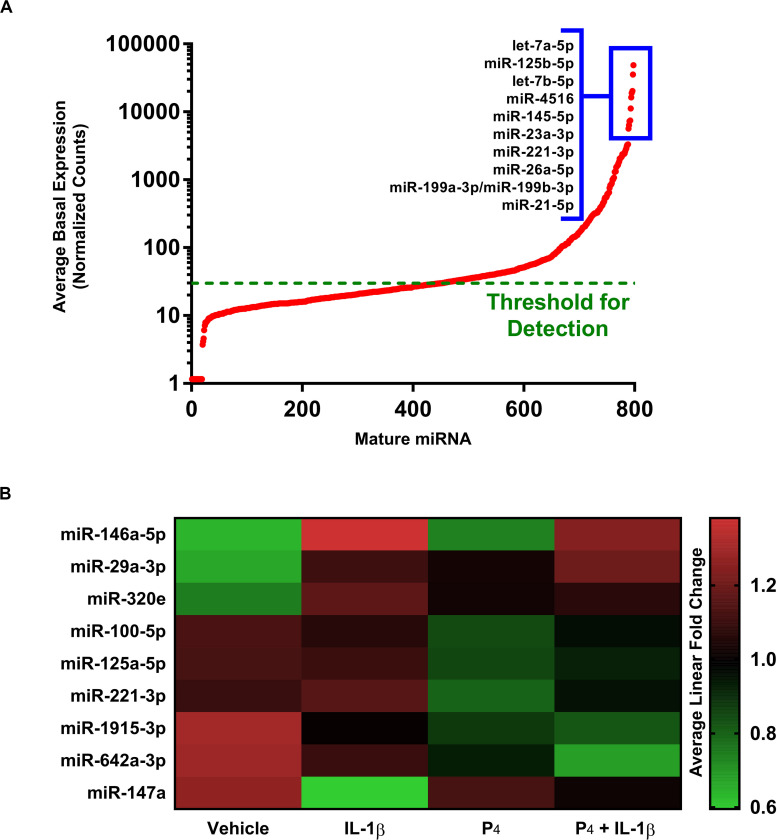
Differential expression of microRNAs in cervical stromal fibroblasts stimulated with IL-1β, P4 or co-incubated with IL-1β + P4. (A) Basal (normalized counts) levels of the most prominently expressed mature miRNAs above the detection limit in cervical stromal cells using the unamplified NanoString® target counting platform. (B) Heat map of differentially expressed mature miRNAs following treatment with vehicle, IL-1β, P4 or co-incubated with IL-1β + P4. Data are from three separate experiments carried out in duplicate.